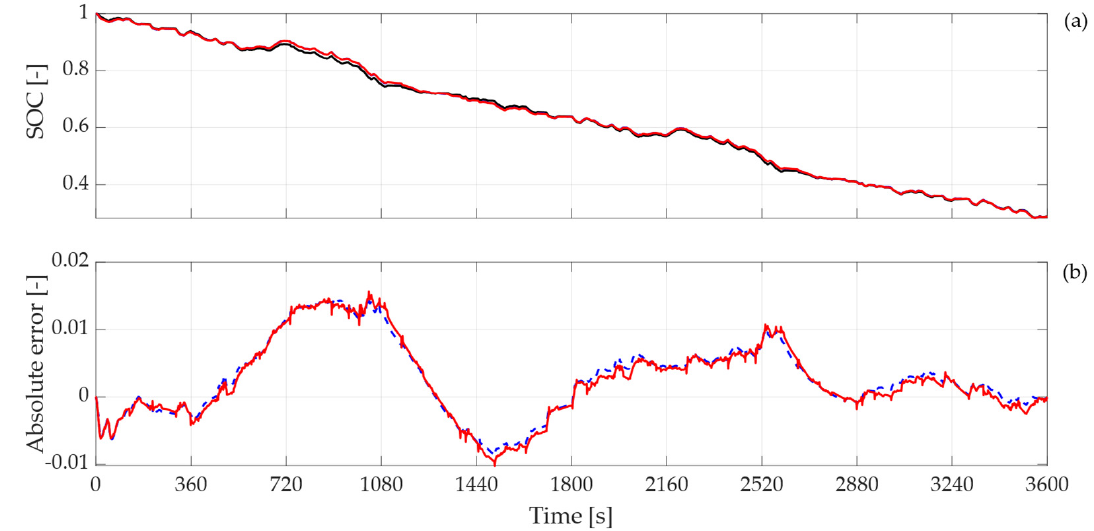
Figure 13. Results on testing dataset A—NARX RNN layout 2: ( a ) reference SOC (solid black line) vs. simulation estimated SOC (solid red line), HIL estimated SOC (blue dashed line) ( b ) absolute simulation error (solid red line), HIL absolute error (blue dashed line).